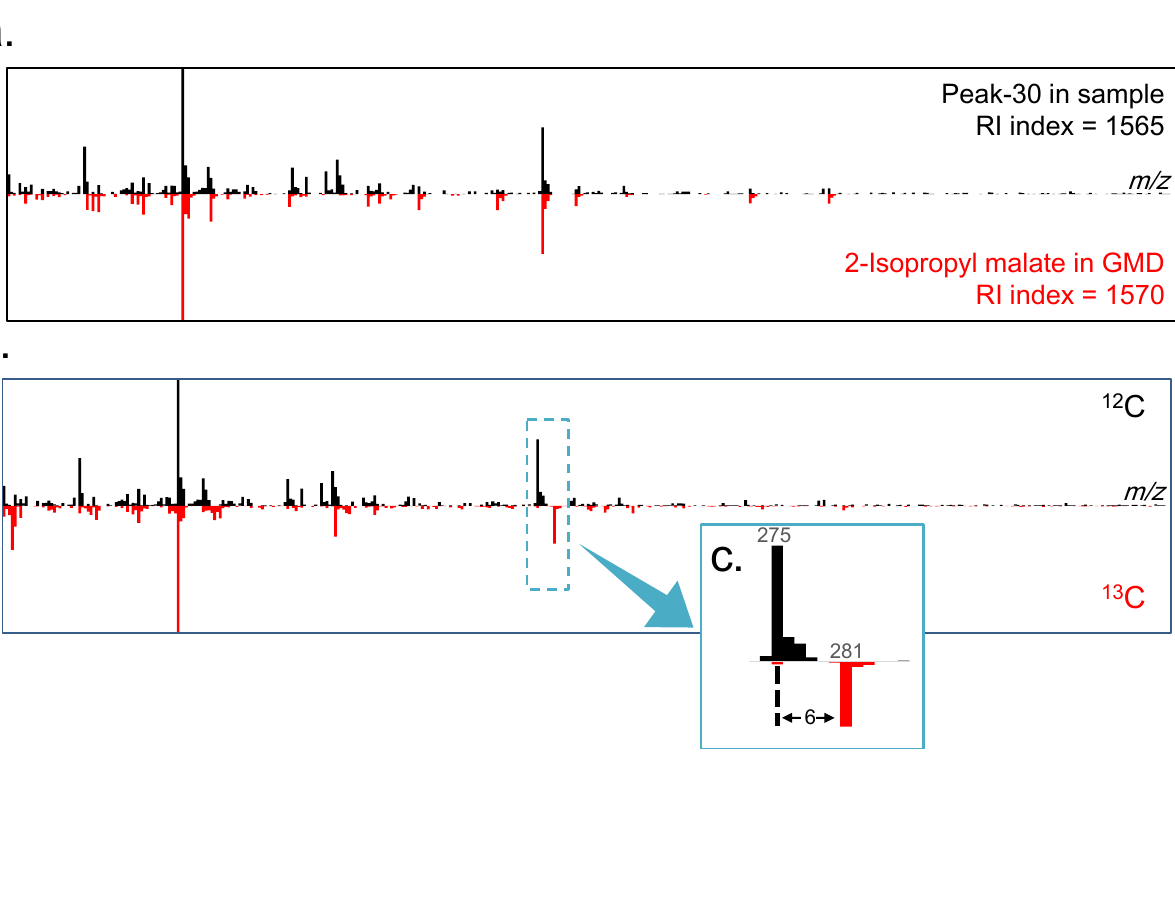
Figure 4. Mass spectra of Peak-30. ( a ) Mass spectra of Peak-30 in the sample ( upper ) and 2-isopropyl malate in the Golm Metabolome Database ( lower ); ( b ) Mass spectra of 12 C- (upper) and 13 C-labeled (lower) Peak-30; ( c ) Magnification of the boxed section in ( b ). Gray numbers indicate the m / z